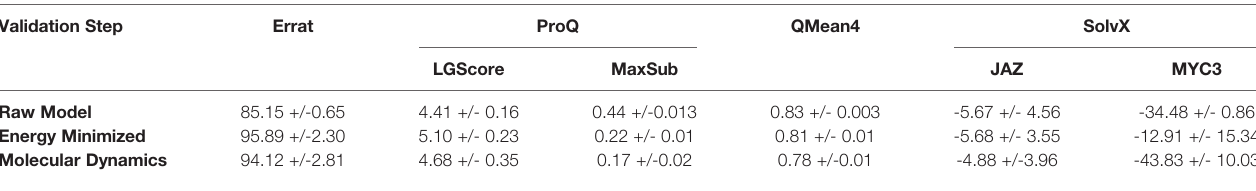
TABLE 2 | Protein structure validation of JAZ-MYC3 homology models.